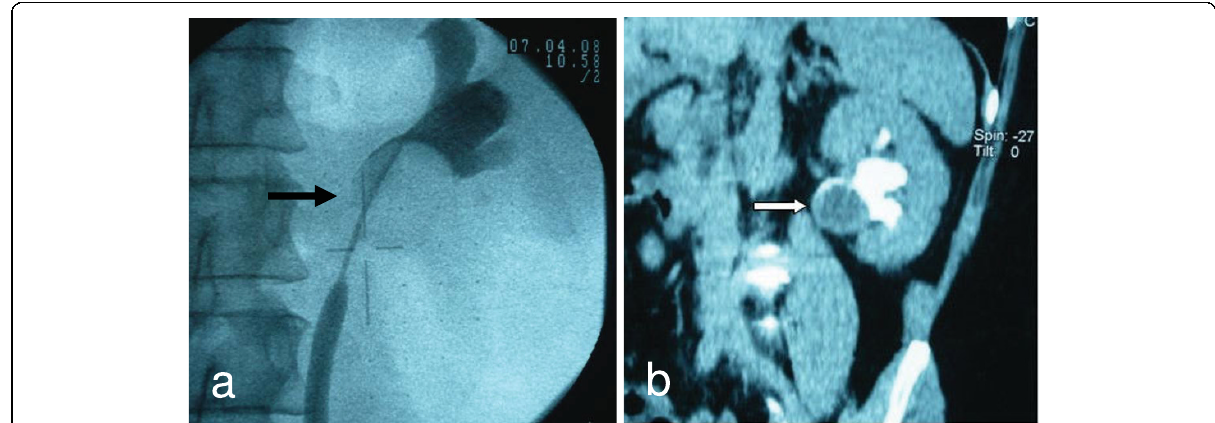
Figure 1 Retrograde ureterography demonstrated a sharply circumscribed tumour mass (black arrow) leading to obstruction of the proximal left ureter (a) . Contrast enhanced CT-Scan showed a homogenous mass located adjacent to the lower hilus of the left kidney (white arrow) without significant contrast enhancement (b) .